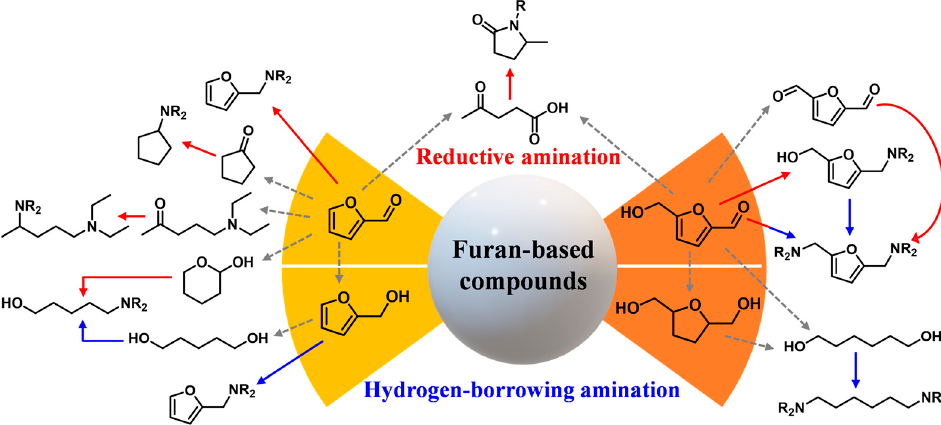
Figure 2. Valorization strategy for bio-based furanic oxygenates by reductive amination and hydrogen-borrowing amination.